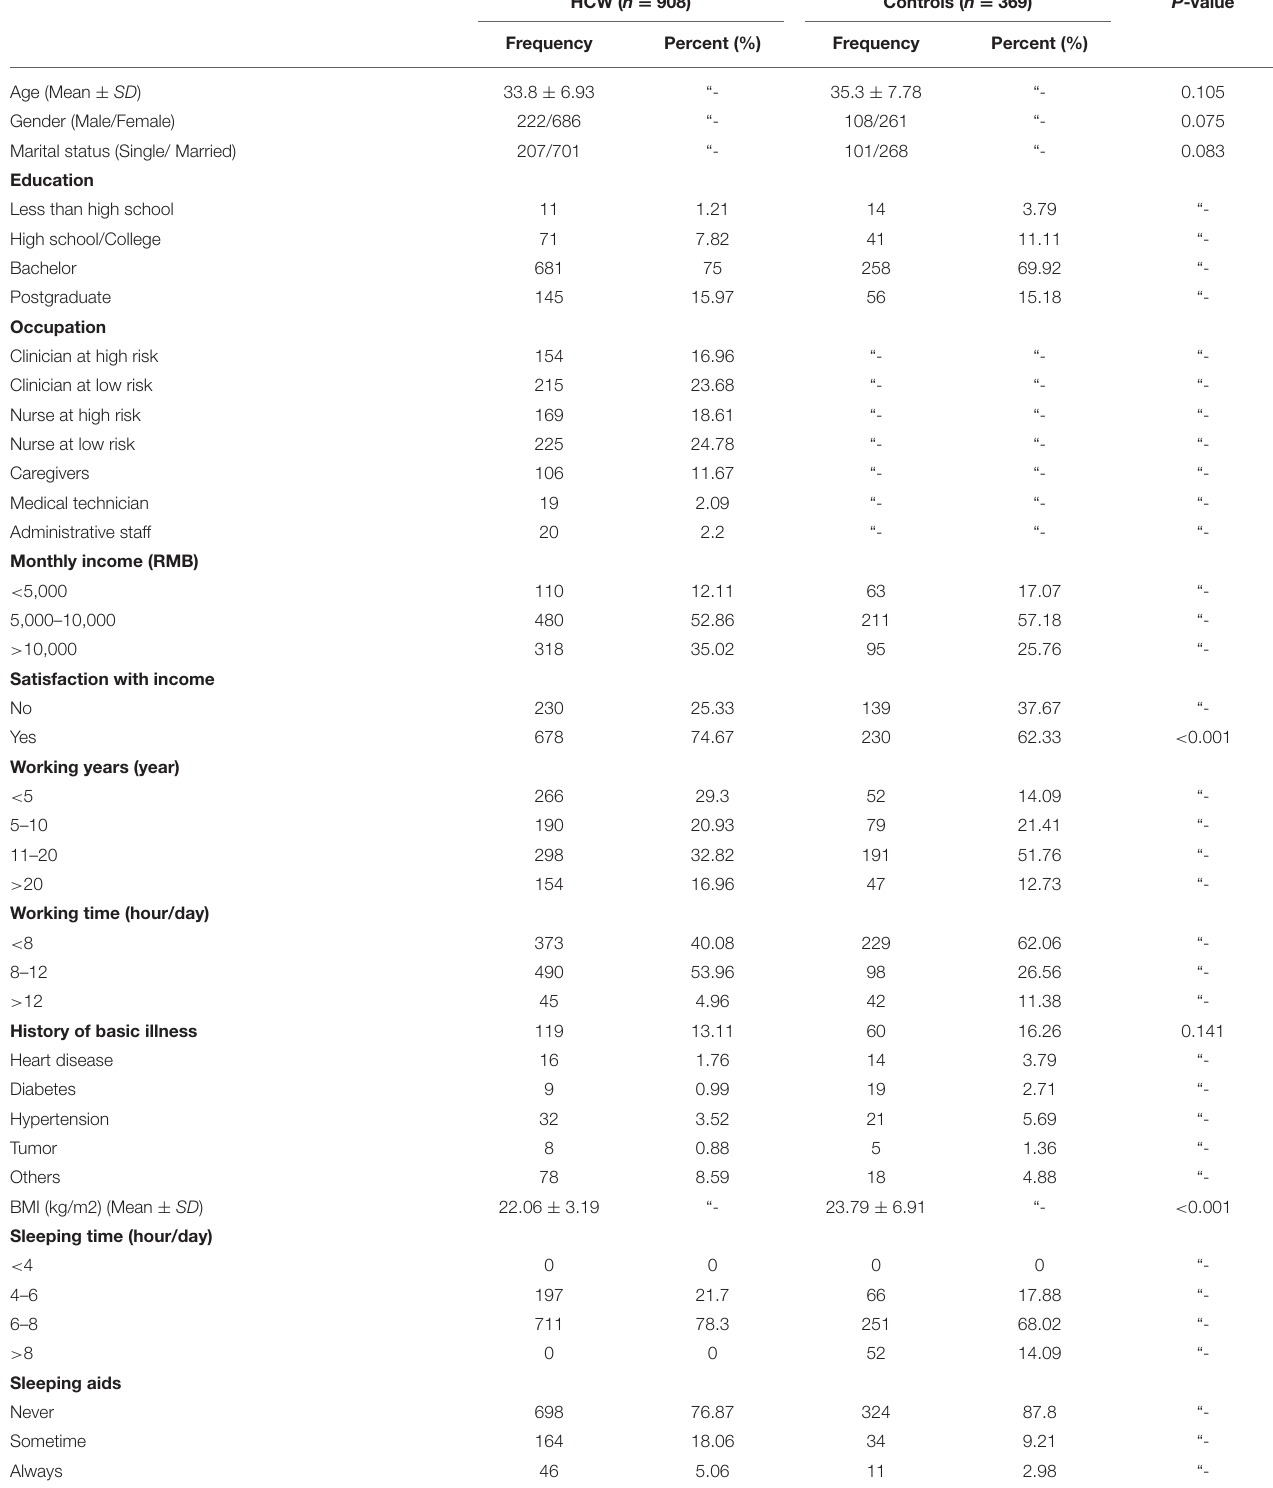
TABLE 1 | Sociodemographic characteristics and information for COVID-19 of healthcare workers ( N = 908) in Guangdong,